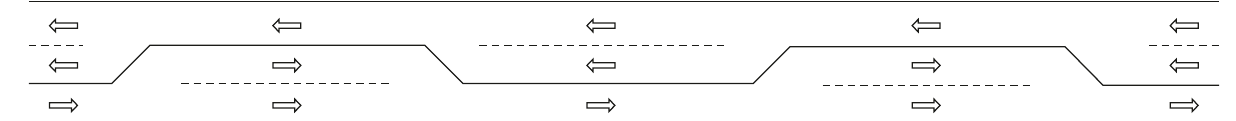
Figure 1: Schematic view of a 2+1